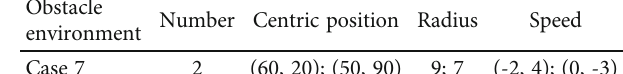
Table 5: Crossing and variation test environment.